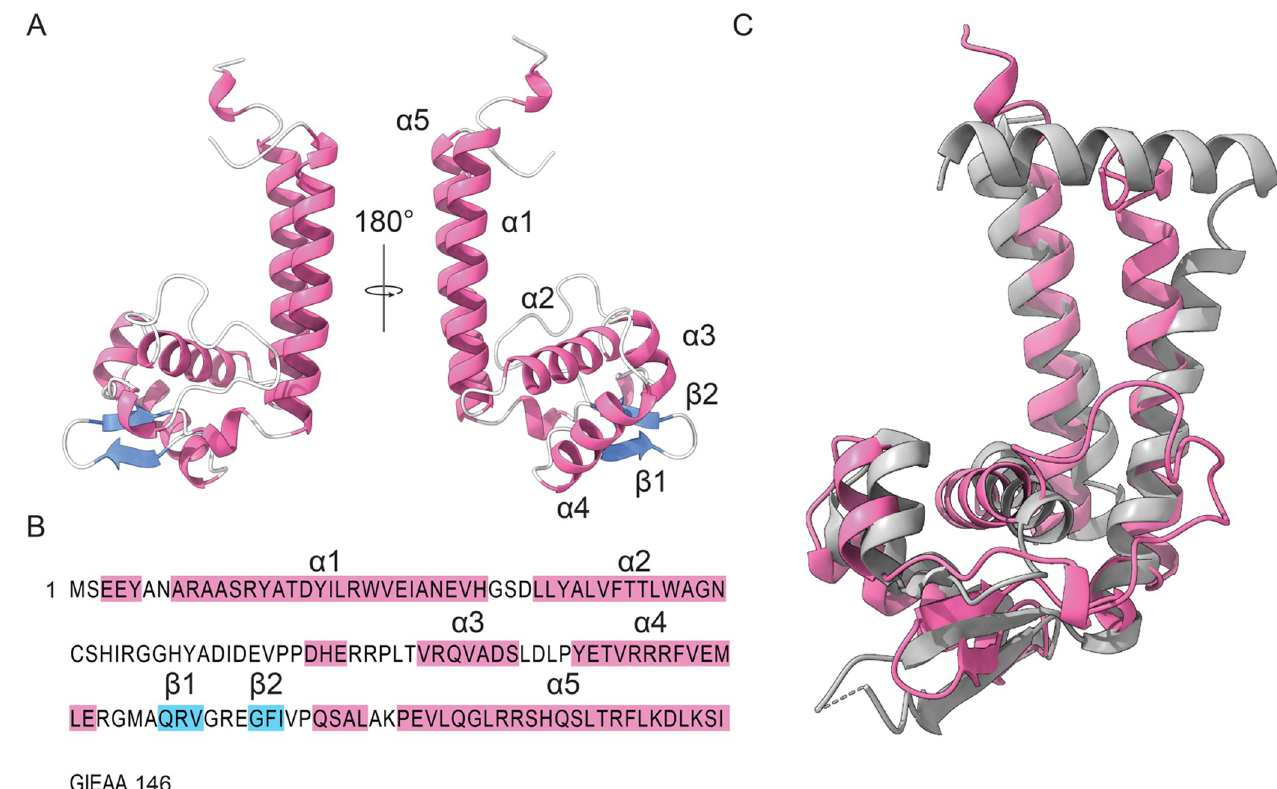
Fig 3. Structural analysis of RtrC. A) Tertiary structure of RtrC predicted by AlphaFold [27]. Pink ribbons indicate alpha ( α ) helices and blue arrows indicate beta ( β ) strands. Labels ( α 1–5 and β 1–2) correspond to the sequence highlighted in panel B. B) Primary structure of RtrC. Amino acids highlighted in pink are in predicted α -helices and residues highlighted in blue are in predicted β -strands, as labeled above the sequence. C) RtrC and MepR superposition. RtrC predicted structure is colored pink and MepR (PDB: 3eco–chain A) is colored grey. Dashed lines indicate missing structure. Superposition performed with the Dali server (Z-score: 10.5, rmsd: 3.3)